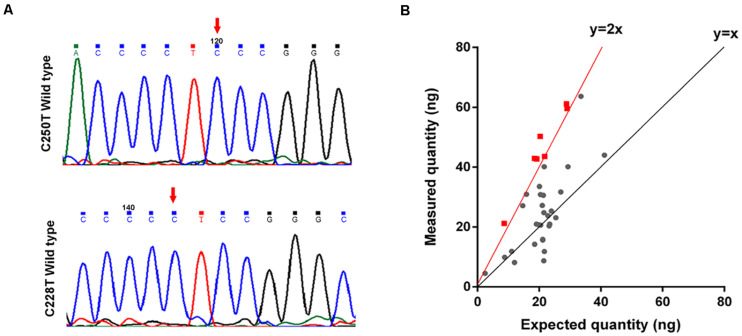
TERT is amplified in some GMs. (A) Chromatogram from Sanger targeted sequencing performed on the TERT promoter at the commonly mutated nucleotides C228T and C250T. No mutation was found in 40 tumors; (B) ddPCR to detect TERT copy number variations (n = 35). The measured quantity of DNA (ng) is plotted against the expected quantity of DNA (ng) where the control is normal DNA. Samples with at least 4 copies/cell (the red dot on the red line or on the left side) were considered to have TERT amplification (n = 7).